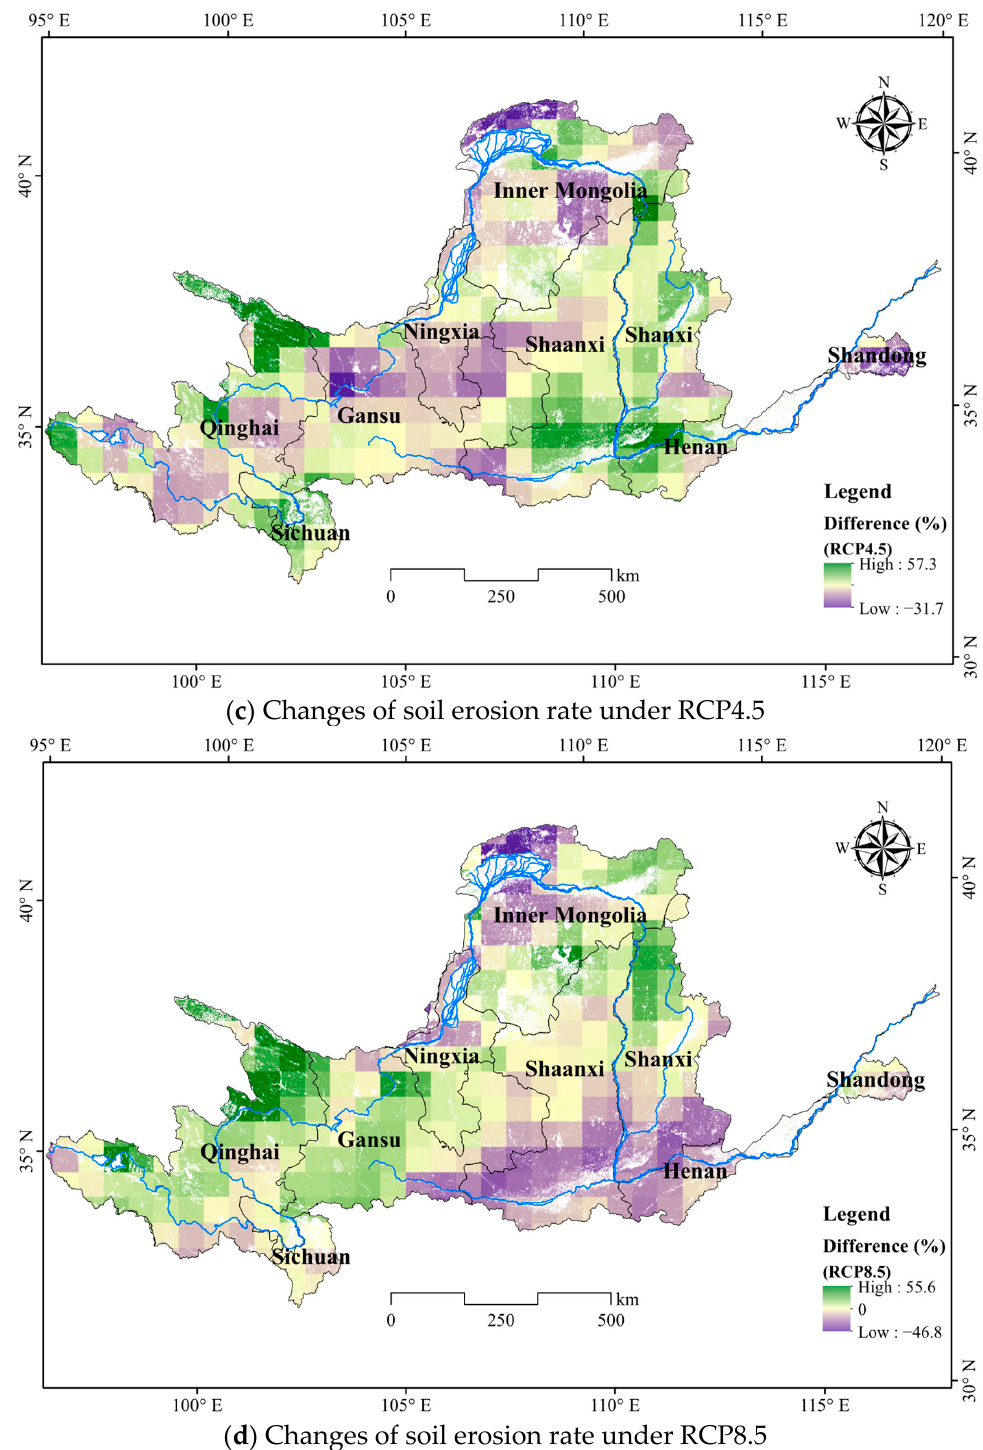
Figure 4. Spatial pattern of soil erosion rates in the YRB with and without irrigation. ( a , b ) depict the soil erosion rate in YRB under N45 and N85 experiments, respectively; ( c , d ) show the corresponding change rate (defined as (Y − N) × 100/N), unit: %) of soil erosion rate with irrigation (Y45, Y85) compared to without irrigation (N45, N85).